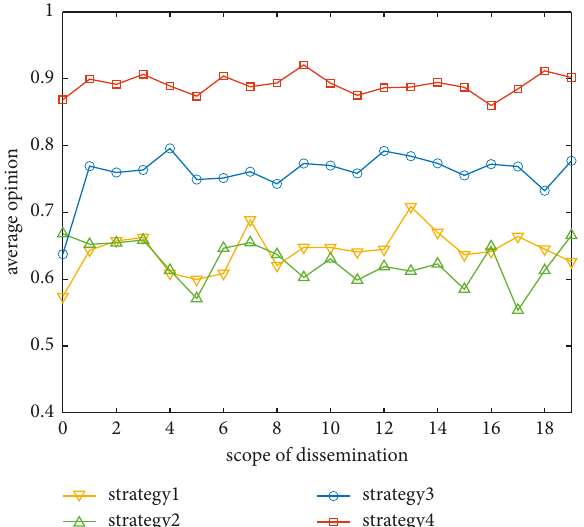
Figure 9: The distribution of the result of average opinion by the guidance from key agents. Strategy A: KAO � 1, A ( 0 ) ∼ U ( 0 , Info ) , limited spreading. Strategy B:KAO �